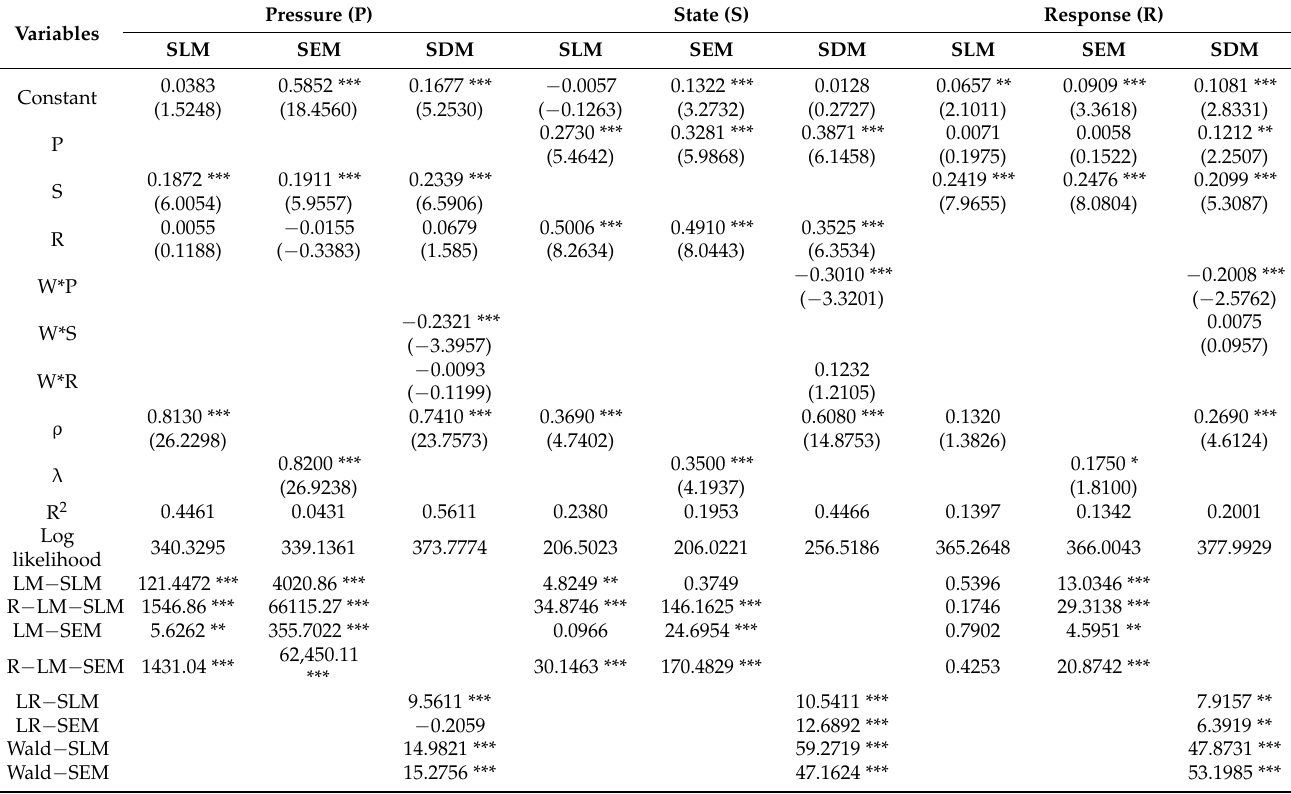
Table 2. Spatial econometric model